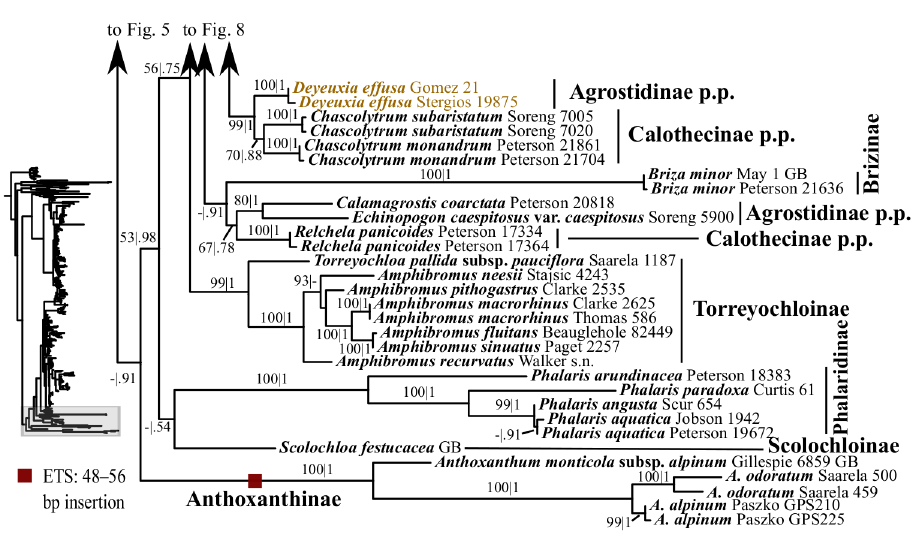
Figure 9. A portion (part of Agrostidinae p.p., Anthoxanthinae, Brizinae, Calothecinae, Phalaridin- ae, Scolochloinae and Torreyochloinae) of the maximum likelihood phylogram inferred from ITS+ETS data. ML bootstrap support (left) and BI poster probabilities (right) are recorded along branches. A dash indicates bootstrap support <50%. No support is shown for branches with bootstrap support <50% and posterior probability <.5. The shaded area of the smaller tree on the left indicates the location in the overall tree of the portion shown. One indel in ETS is mapped onto the